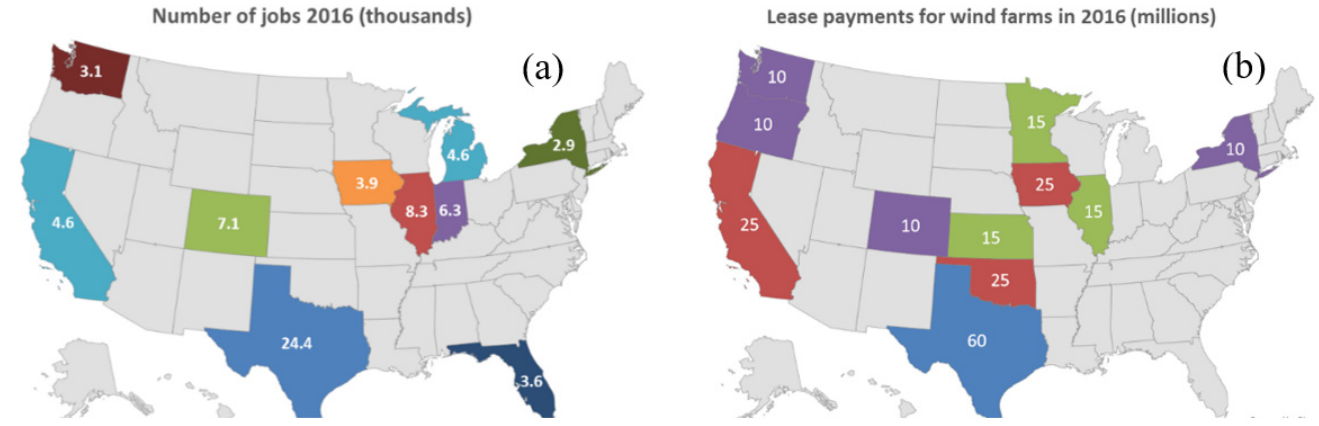
Figure 1. Wind energy benefits per states for 2016. ( a ) Number of jobs. ( b ) Lease payments. Evaluating the distribution of benefits among diverse rural populations is important to avoid perceptions of the concentration of these advantages on limited number of stakehold- ers. As granular and higher resolution results are able to show the dispersion of financial